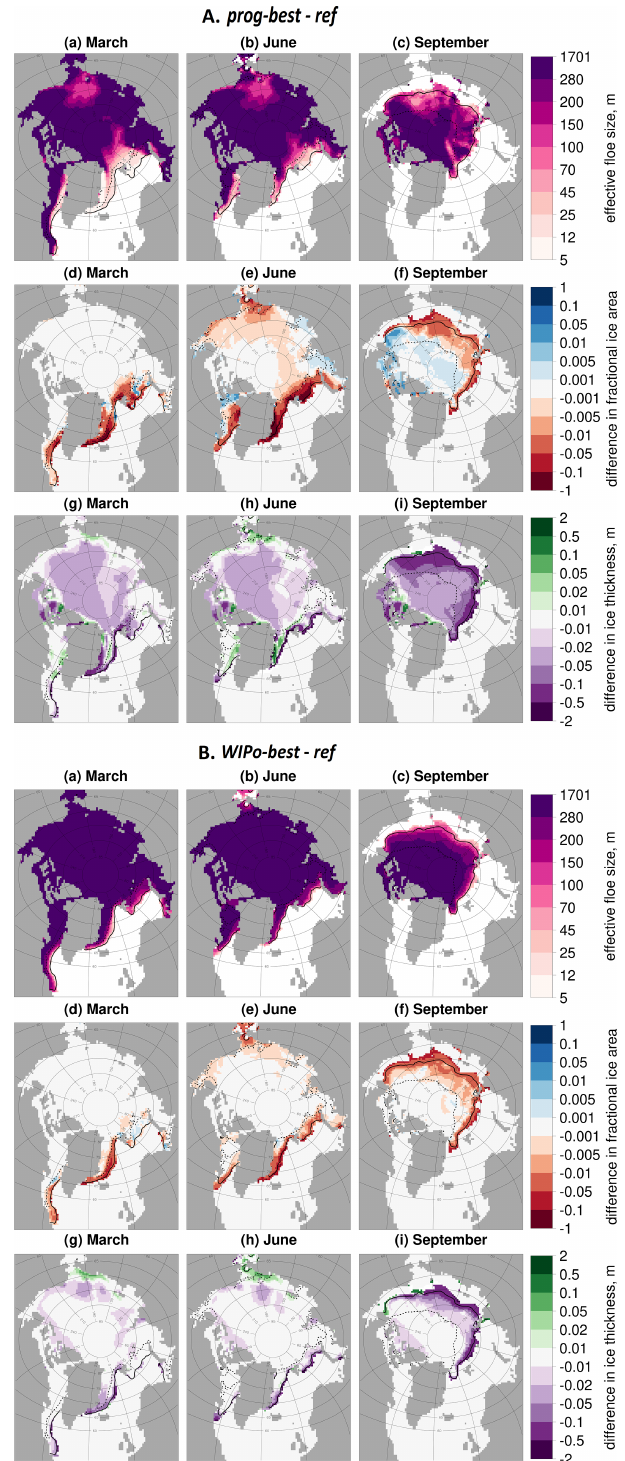
Figure 10. Absolute values of l eff (a–c) for prog-best (A) or WIPo-best (B) and the difference in sea ice area fraction (d–f) and difference in ice thickness (g–i) between prog-best (A) or WIPo-best (B) and ref averaged over 2000–2016. Results are presented for March (a, d, g) , June (b, e, h) , and September (c, f, i) . Values are shown only in locations where the sea ice concentration exceeds 5%. The inner (dashed black) and outer (solid black) extent of the MIZ averaged over the same period is also